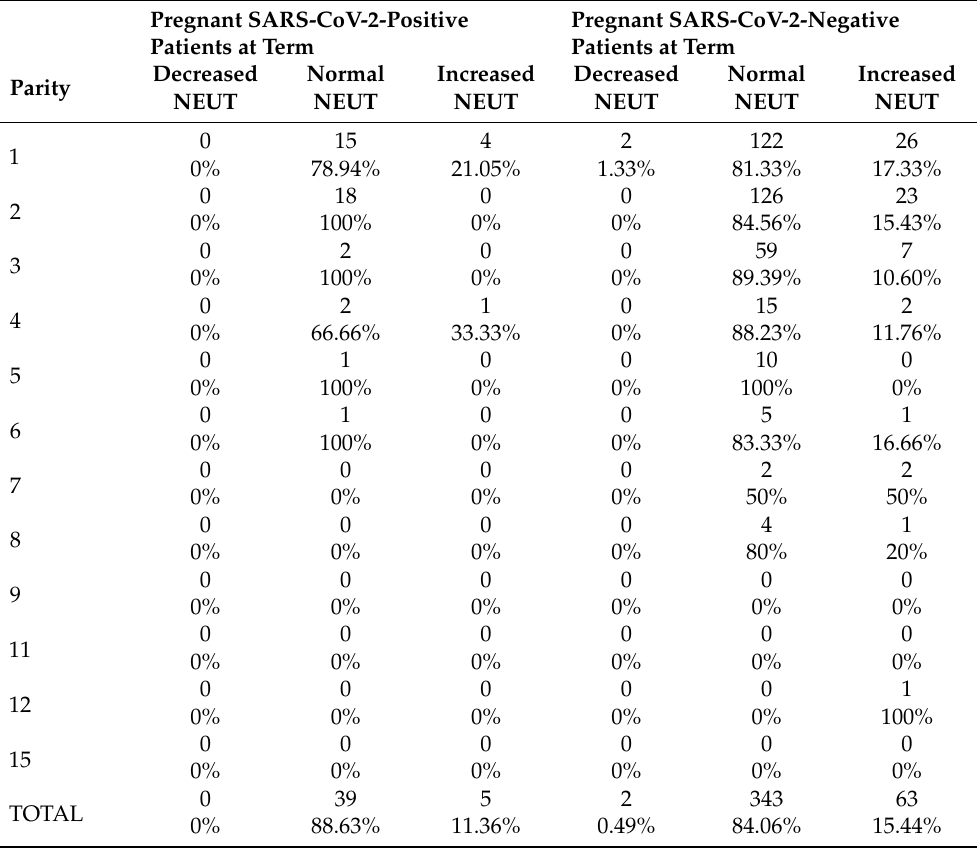
Table 11. Number and percentage of pregnant patients with a normal, increased, and decreased number of neutrophils (NEUT), as regards